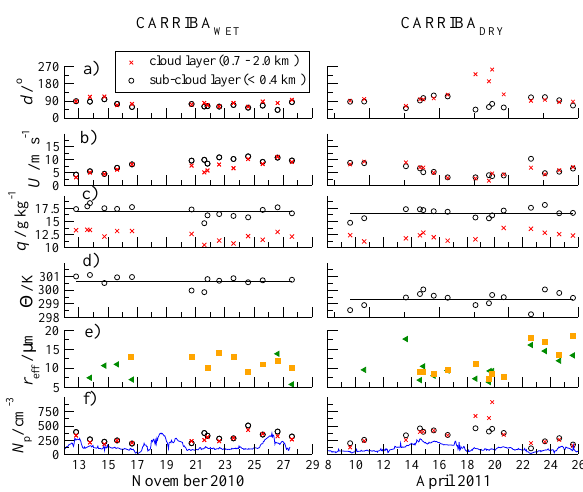
Fig. 6. Overview of the meteorological situation during CARRIBA WET and CARRIBA DRY . Displayed are mean val- ues representative for the SCL below 400m (black circles) and the cloud-free layer in the height range between 0.7 and 2.0km (red crosses). Only data from over the ocean is considered for the SCL height. Displayed are the mean wind direction d , the mean horizontal wind velocity U , the specific humidity q , the potential temperature 2 , and the aerosol particle number concentration N p . The solid blue line represents the particle number concen- tration with diameters > 80nm (a proxy for CCN at S ≈ 0 . 2%) as continuously measured at Ragged Point. The mean effective radius r eff is estimated for cloud fields in the height range between 0.7 and 2.0km, the orange symbols are in situ estimates derived from the PDI and the green symbols are retrievals from radiation measurements representative for cloud